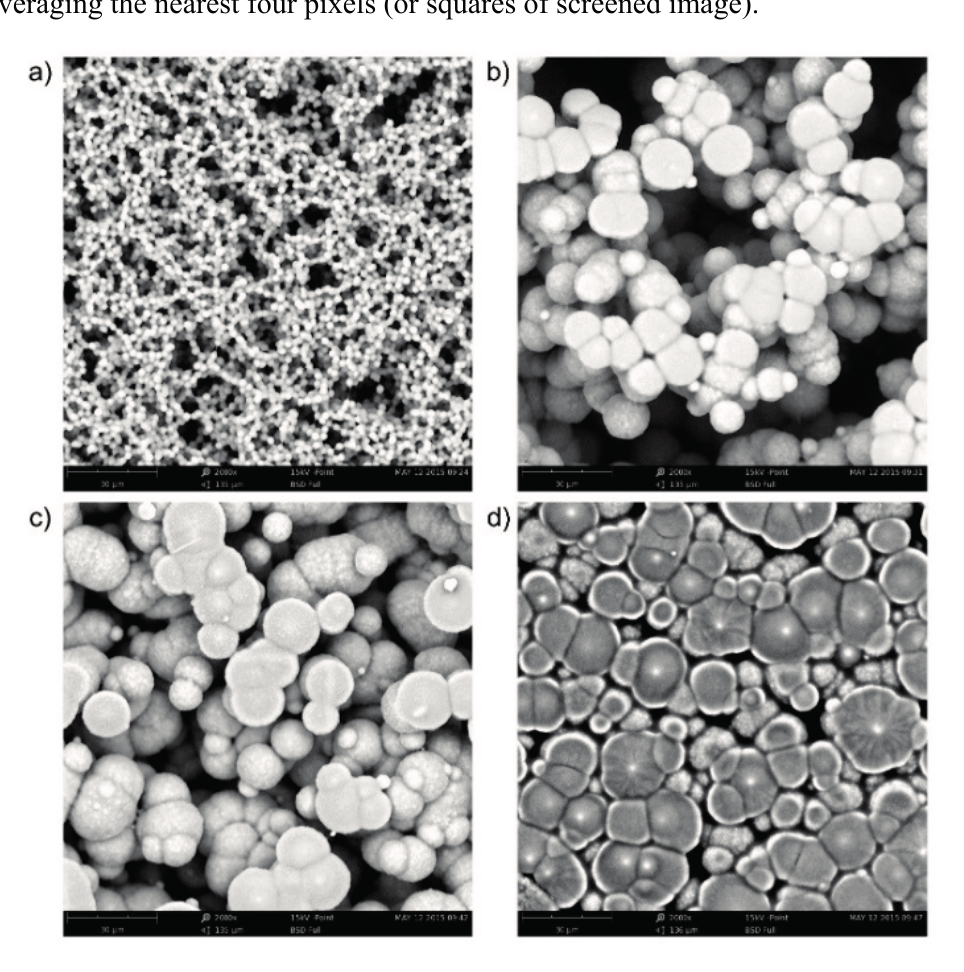
Figure 5. Morphology of the SPE layer based on [EMIM][N(Tf) 2 ] ionic liquid under different thermal treatment conditions (Phenom ProX electron microscope, magnification 2000×): ( a ) 80 °C for 1.5 min; ( b ) 120 °C for 1.5 min; ( c ) 120 °C for 3.5 min; ( d ) 160 °C for 10